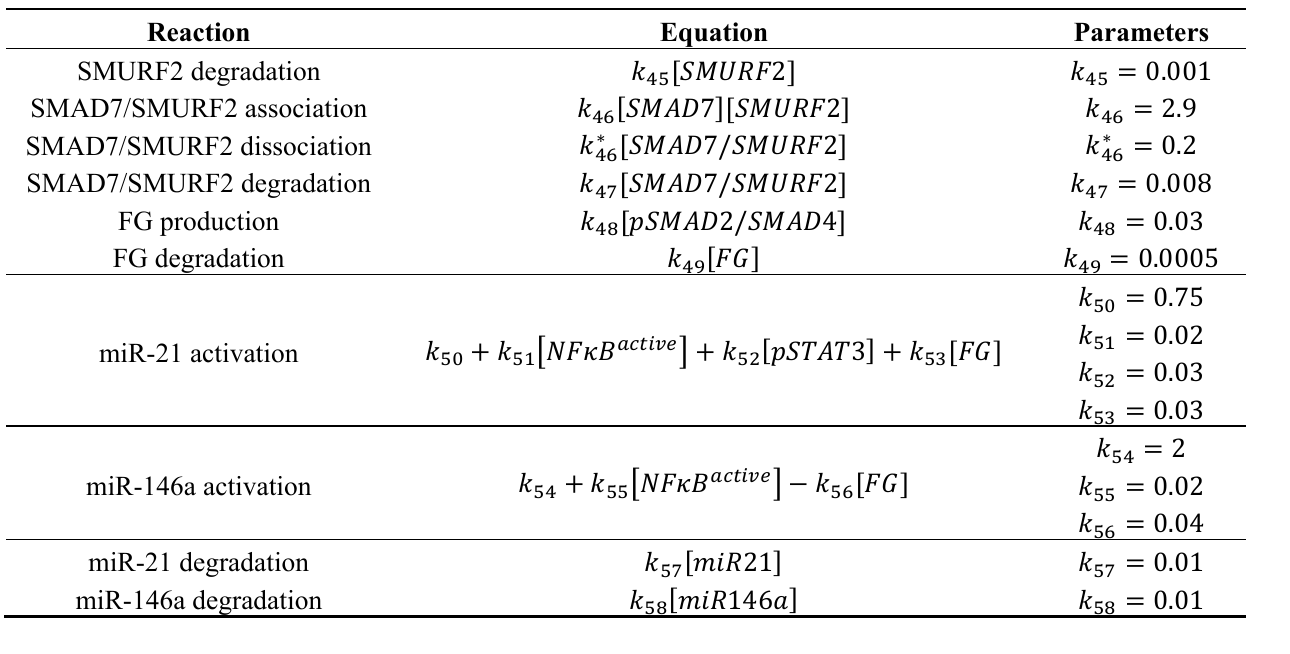
Figure A1. Schematic ( A ) and Petri net ( B ) representations of the IL-1/NF- κ B network simulated in Figure